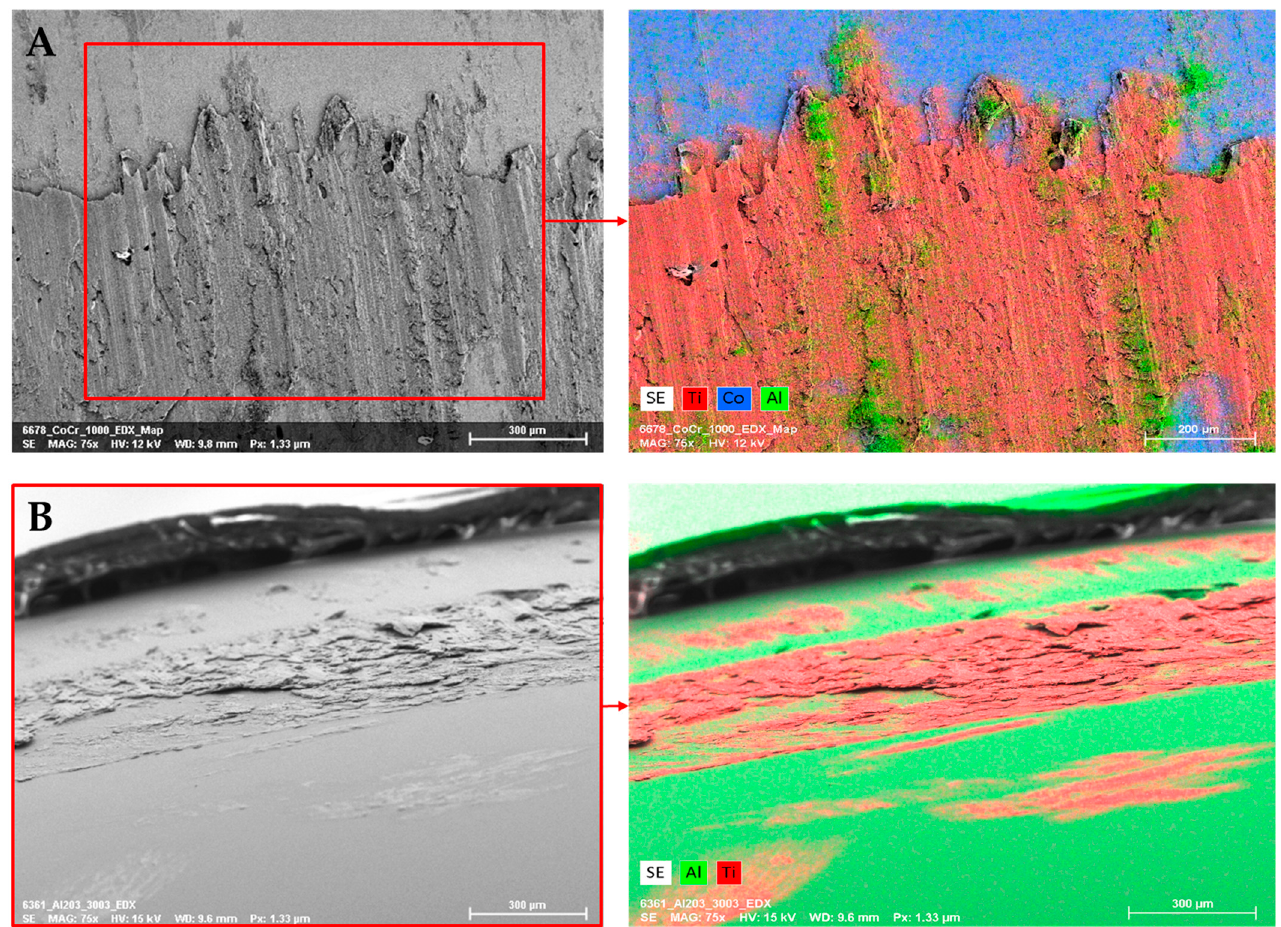
Figure 7. EDX mapping on retrieved femoral heads; ( A ) metallic deposit containing Ti and Al on CoCr femoral head and ( B ) metallic deposit containing Ti on alumina ceramic head. Table 4. Detected deposition materials on femoral